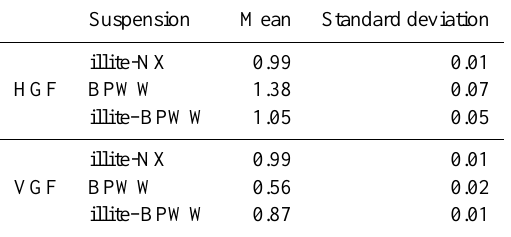
Table 1. Mean value and standard deviation of the HGF and VGF Gaussian distribution for the different heated (V) and humidified (H) particle types. The selected size prior to the treatment was